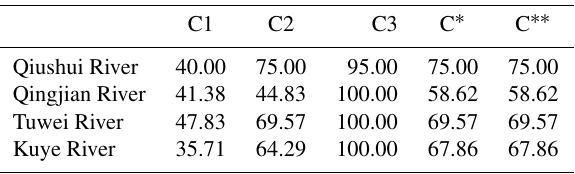
Table 5. The percentage of modeled peak flows that meet various conditions for the VMM. Values are given as a percentage. C1 C2 C3 C ∗ C